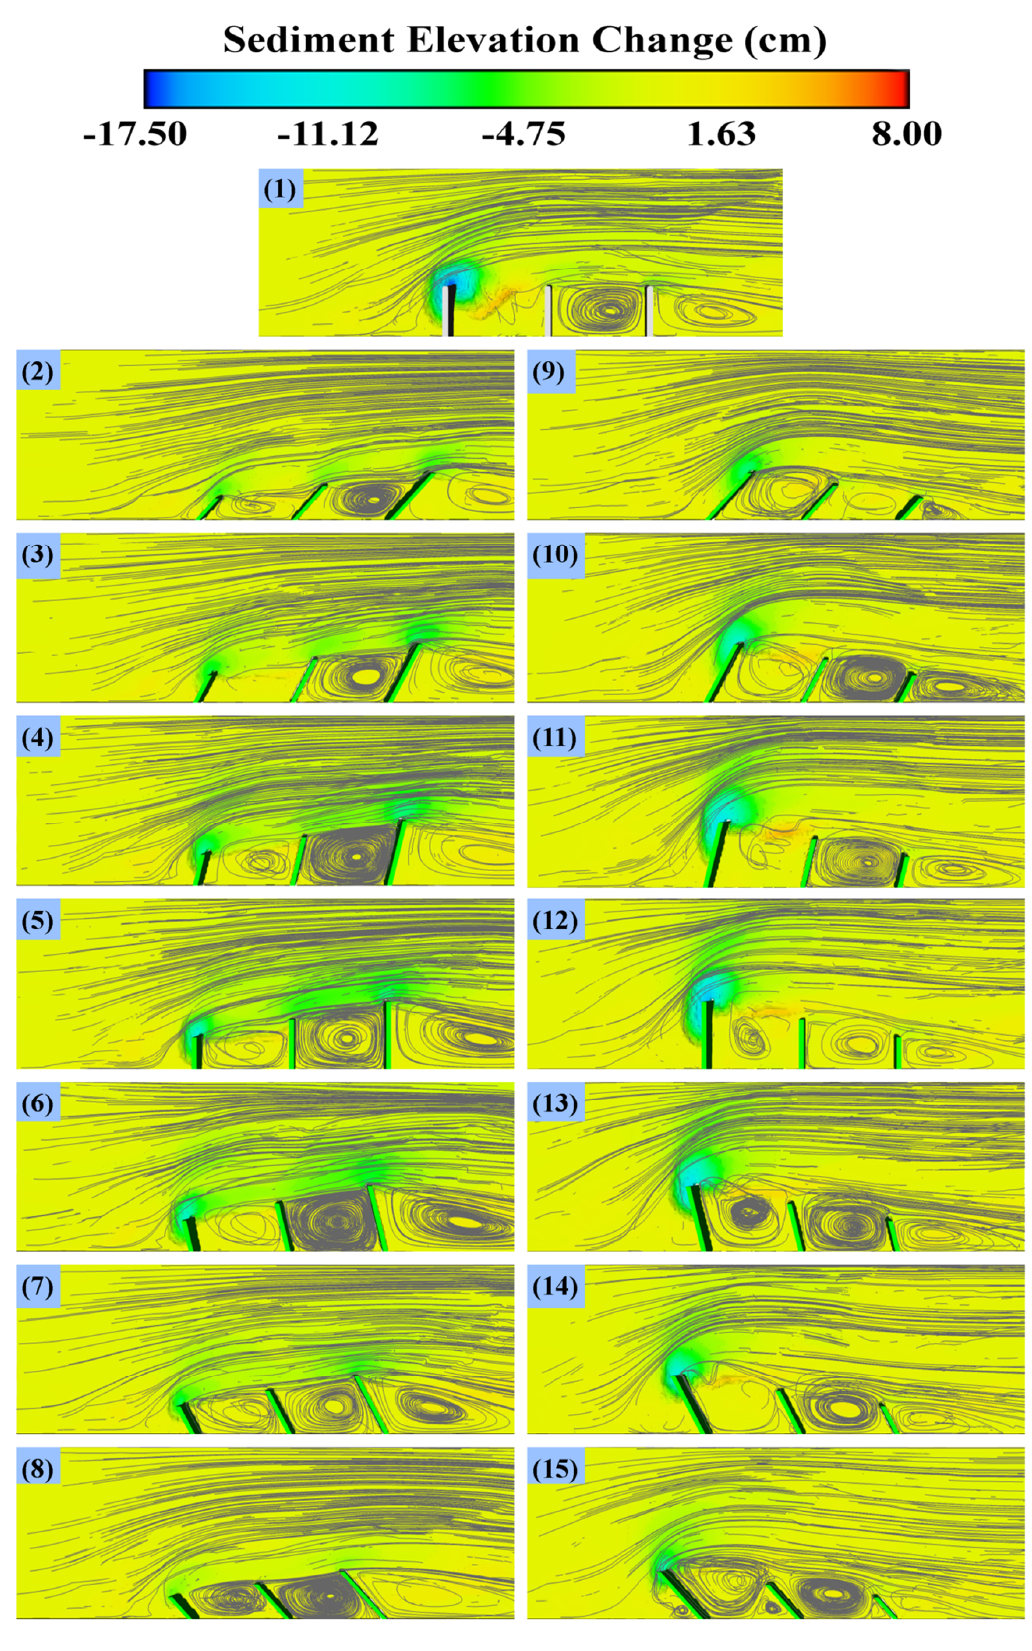
Figure 11. Vortices around groynes under simulations 1–15.